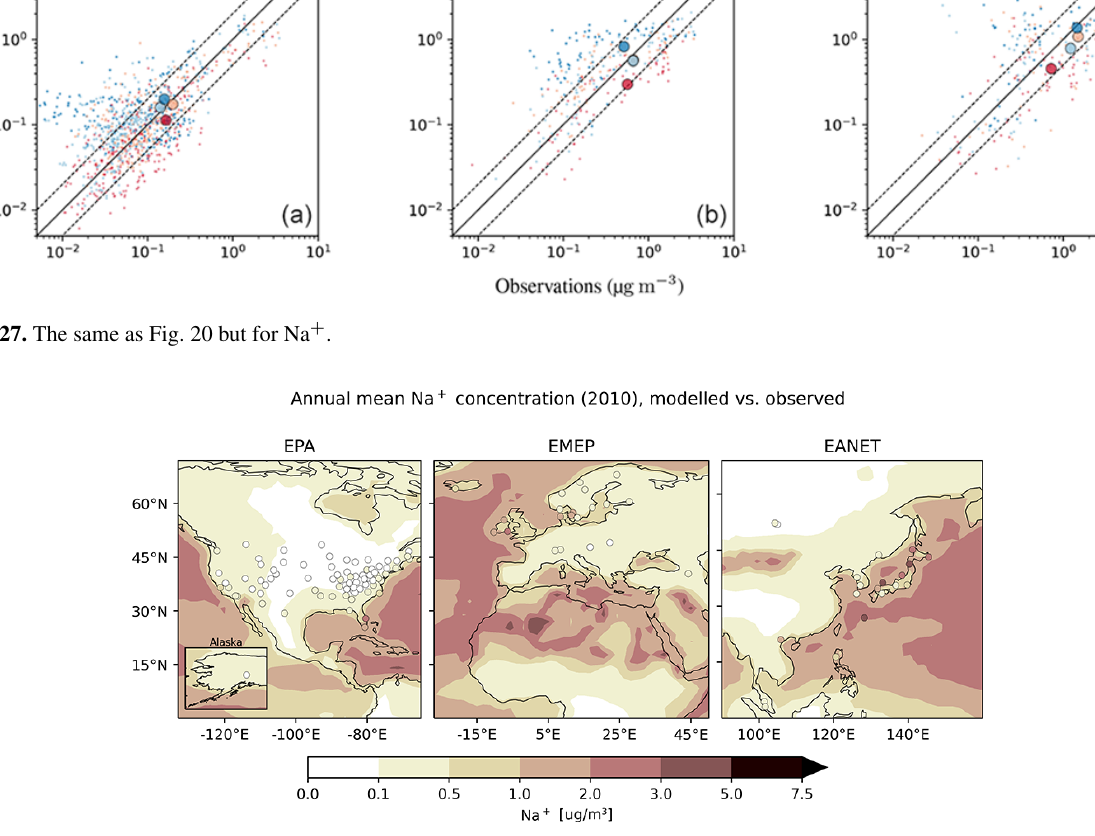
Figure 28. The same as Fig. 21 but for Na +